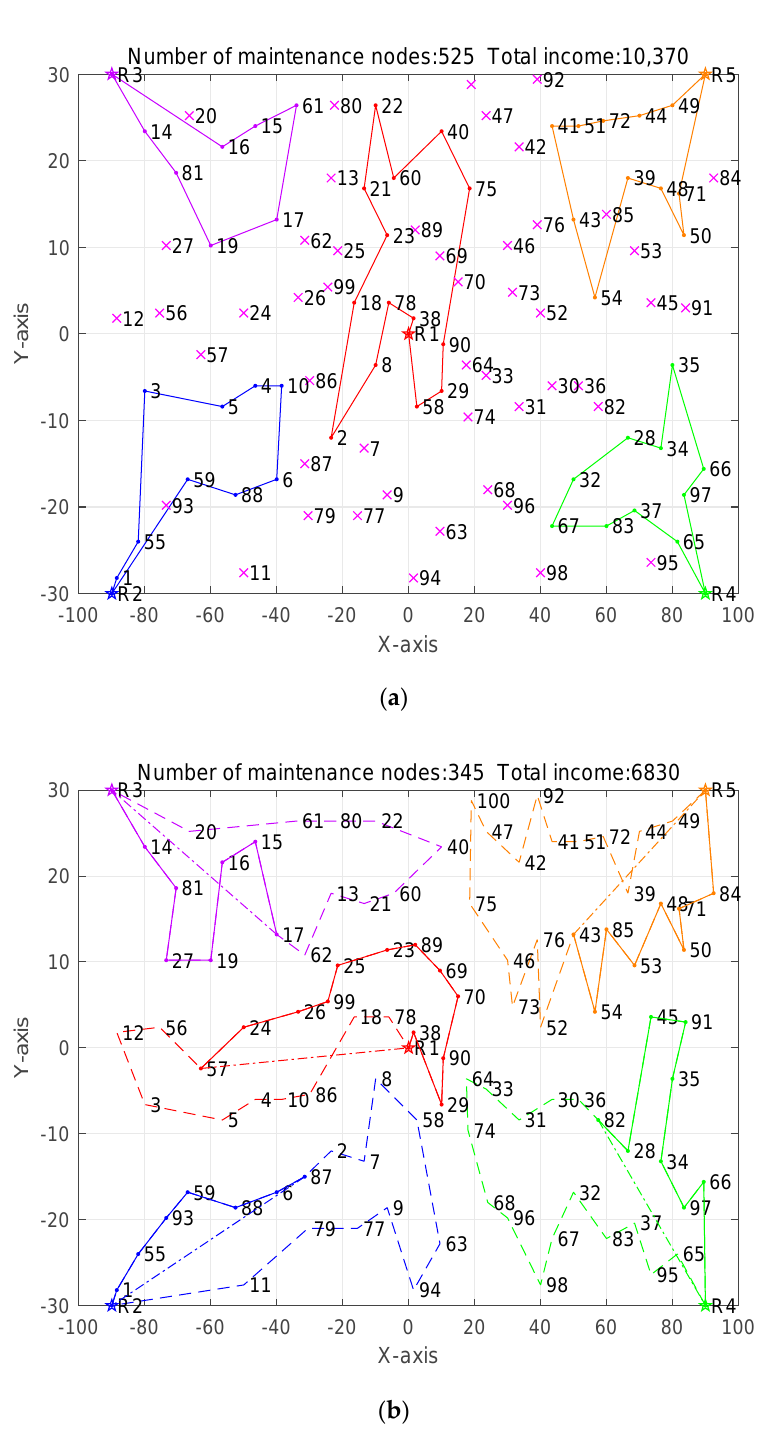
Figure 3. Comparison of maintenance routes when the space-robot cluster energy is 5000. ( a ) Optimal-path model; ( b ) shortest-path model.